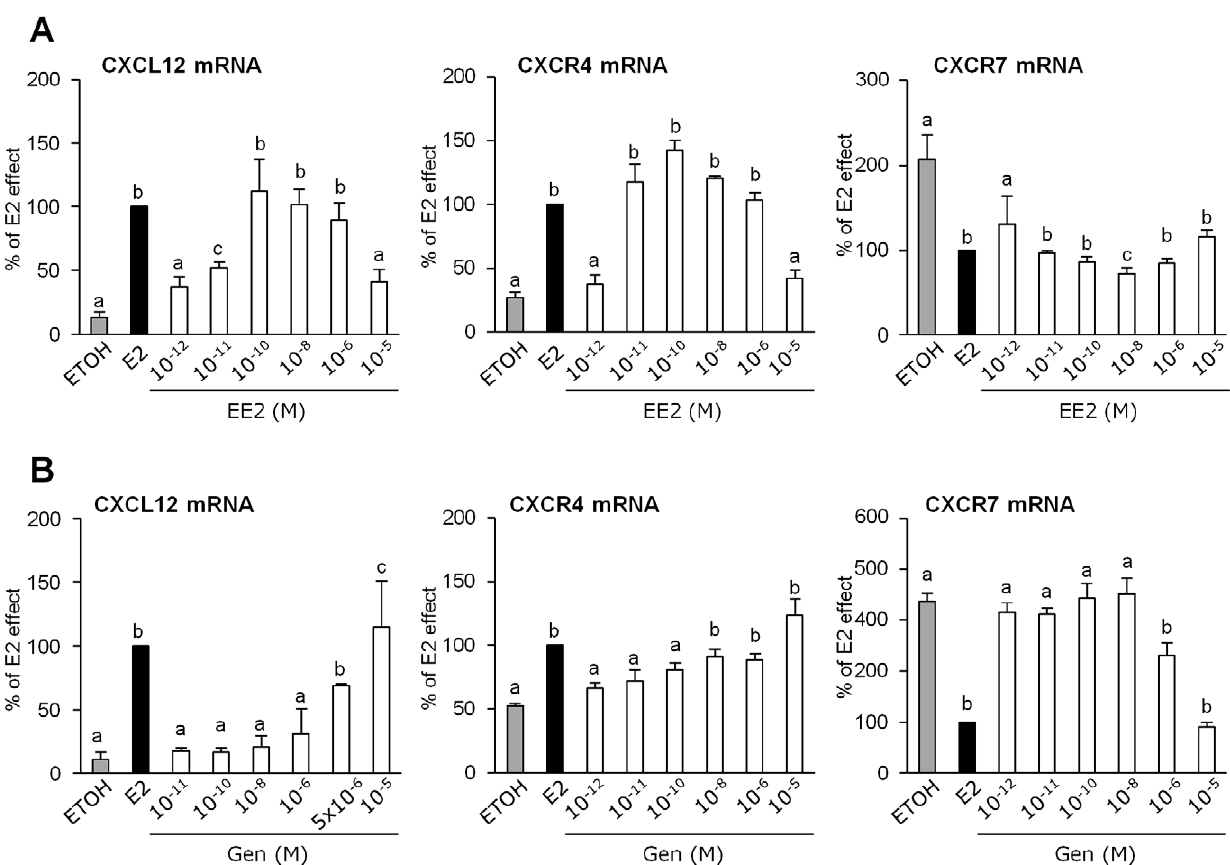
Figure 3. Xeno-estrogen effects on the expression of CXCL12, CXCR4 and CXCR7 in MCF-7 cells. The levels of the CXCL12, CXCR4 and CXCR7 transcripts were assessed by quantitative real-time PCR in MCF-7 cells treated under various conditions for 48 h. Treatment with EtOH and 10 2 8 M E2 served as the negative and positive controls, respectively. In each experimental assay, the cells were exposed to different concentrations of 17 a -ethynyl-estradiol (EE2) (A) and Genistein (Gen) (B). Transcript levels were normalized against GAPDH mRNA, and data were calculated as percentage of the E2 effect for each experiment. Significant differences (P , 0.05) are indicated by different lowercase letters.